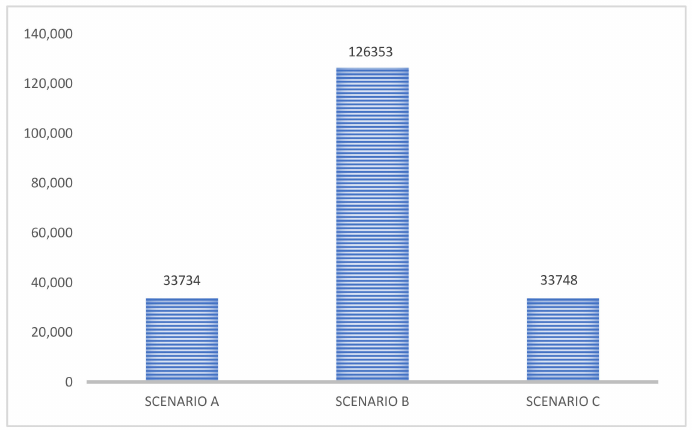
Figure 11. Global warming kg CO 2 -life-cycle stages.